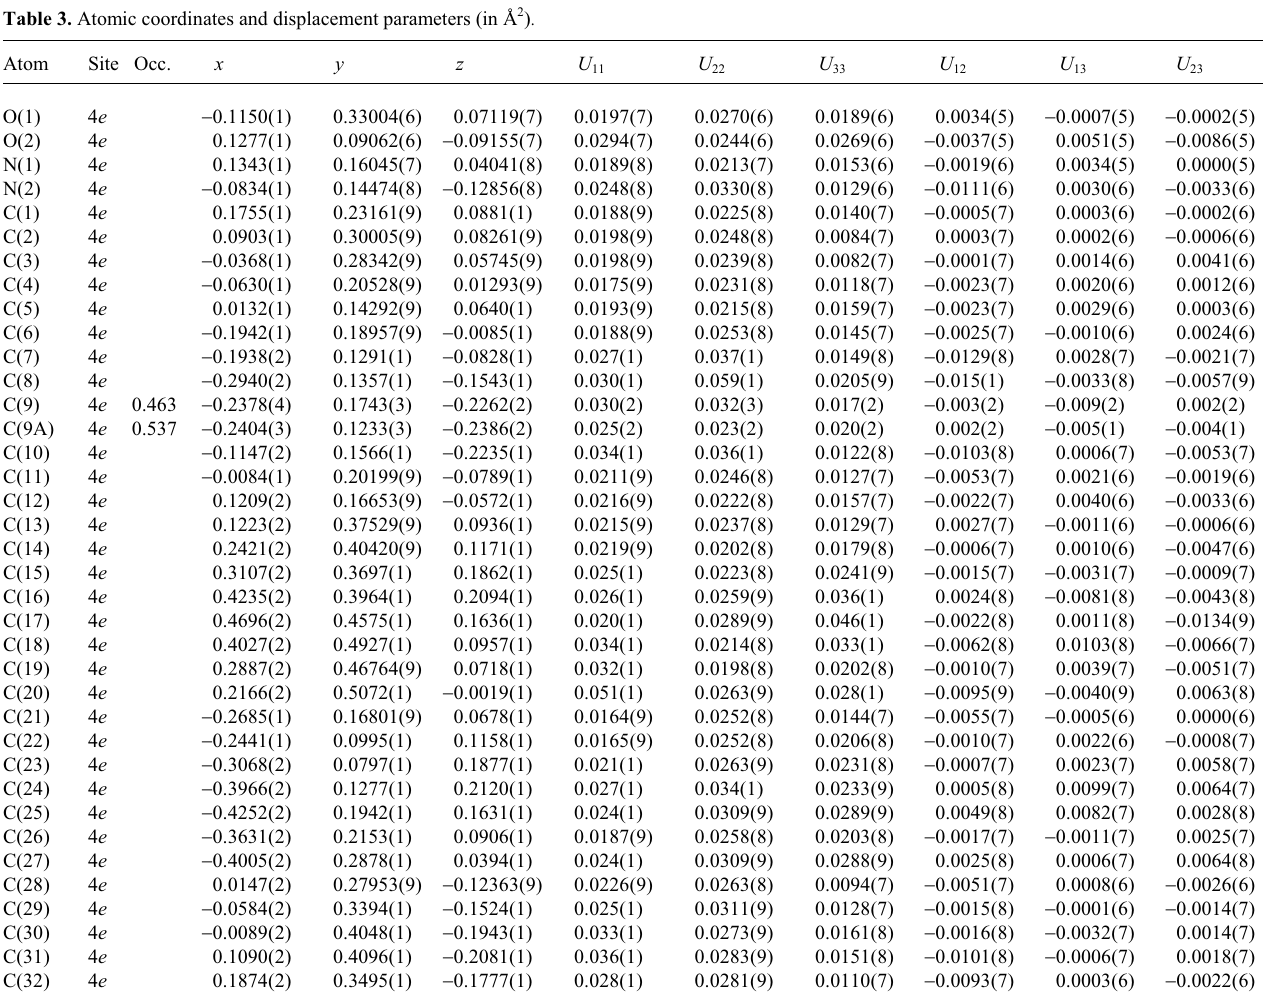
Table 3. Atomic coordinates and displacement parameters (in Å 2 )